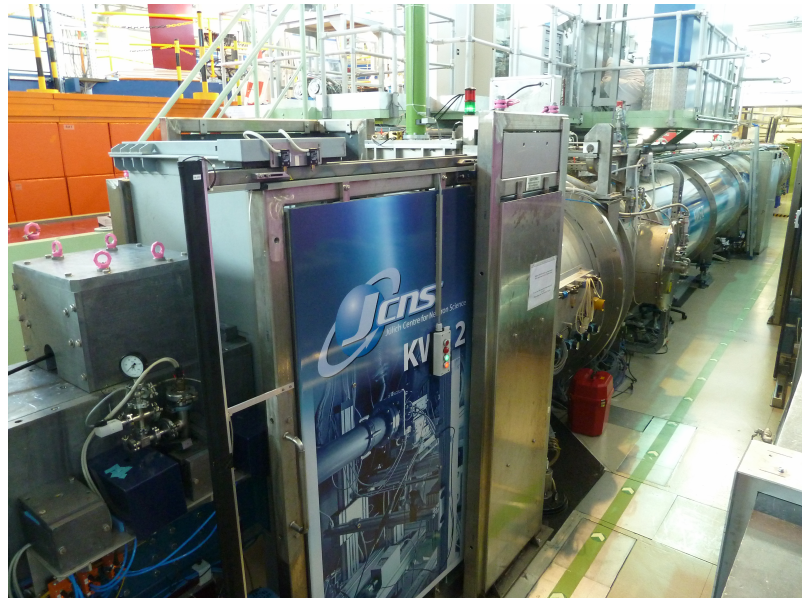
Figure 1: Instrument